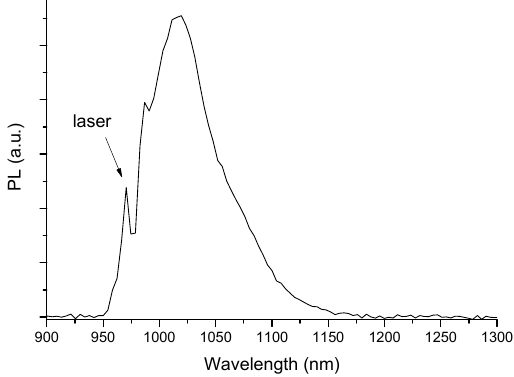
Figure 13. PL emission spectrum of an active disk (BM/71 SiO 2 -14 AlO 1.5 -15 YbO 1.5 film, 36.3 μ m thick/ARC), excited at 970 nm.